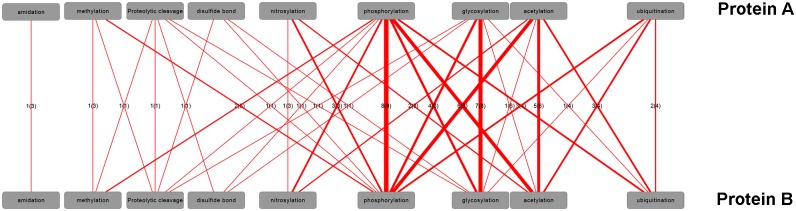
Pairwise interactions of proteins carrying different PTM-types (one-PTM-type-only dataset, see Methods).Number of species with statistically increased frequency of protein-protein interactions (designated as protein A and B, respectively) carrying the respective PTM-types. Linewidth is set proportional to the number of species (indicated as edge labels), which exhibit significant interactions of PTM-types carried by interacting proteins. The value in the parentheses corresponds to the number of common species with available PTM and PIN information. The contingency table for the Fisher exact test contained the respective counts for number of proteins associated with a particular PTM-pair versus all alternative pairings and whether they have been reported to interact or not with FDR-corrected p-value <0.01. Note that the counts of pairwise interactions between protein A and B are by definition symmetric. Hence, labels were added to one direction only. Sumoylation, hydroxylation, and carboxylation were left out because no related significant interactions were found.